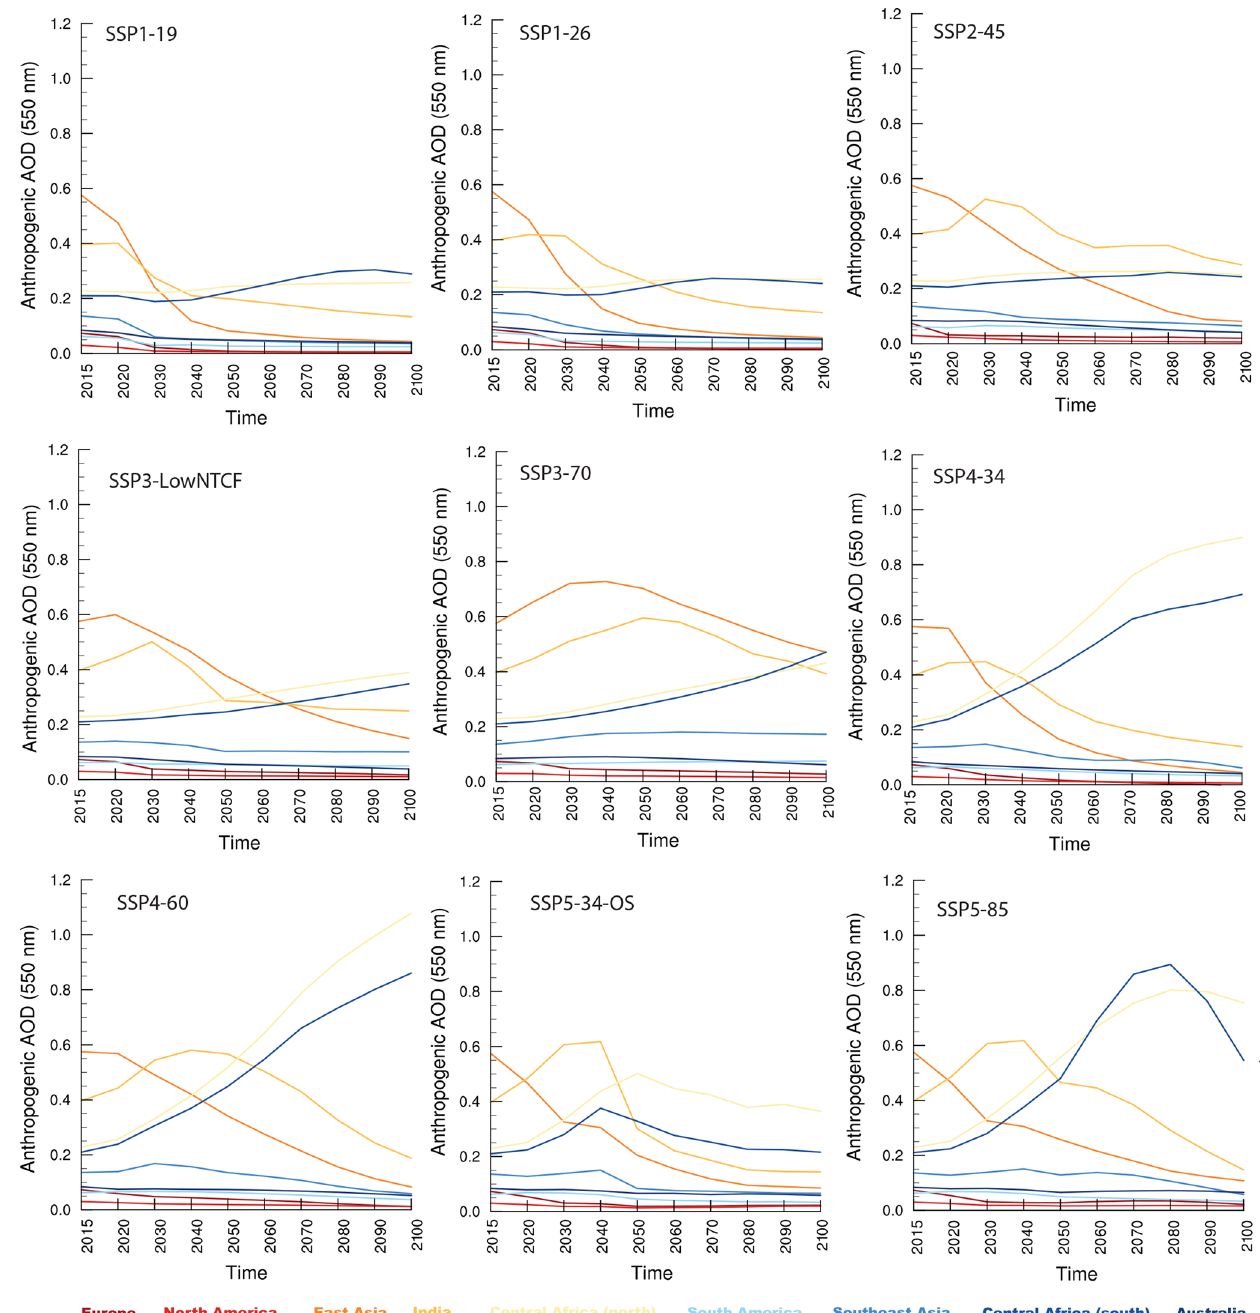
Figure 2. Future τ i in the MACv2-SP interpretation of CMIP6 scenarios. Shown are the temporal developments of the anthropogenic aerosol optical depth, τ , at 550nm in the colour-coded aerosol plumes of MACv2-SP for the nine emission scenarios of CMIP6.